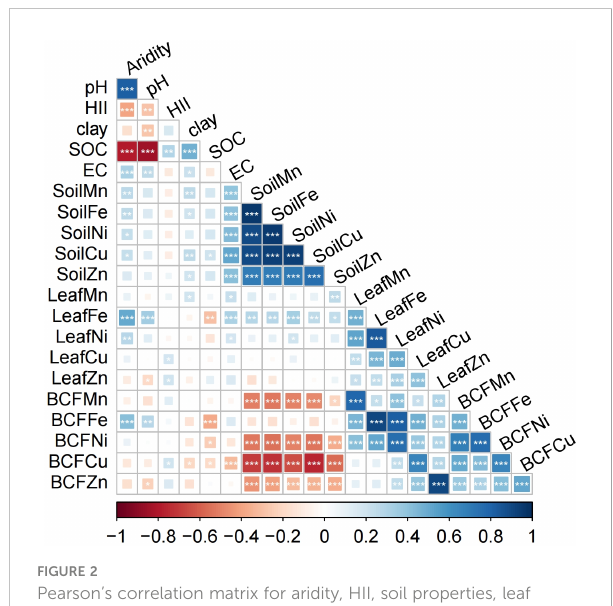
FIGURE 2 Pearson ’ s correlation matrix for aridity, HII, soil properties, leaf microelement concentrations and bioconcentration factors (BCFs). HII, human impact index; SOC, soil organic carbon; EC, soil electrical conductivity. Blue squares are positive correlations and red squares are negative correlations. * P < 0.05, ** P < 0.01, *** P <